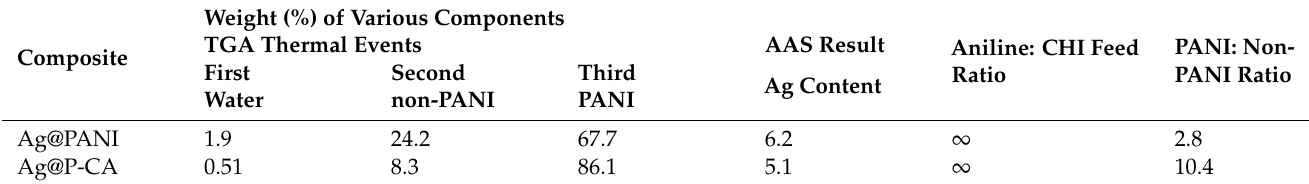
Table 1. Estimated composition (wt.%) of different PANI-based and organic components of the composite based on TGA and Ag content based on AAS results. 1